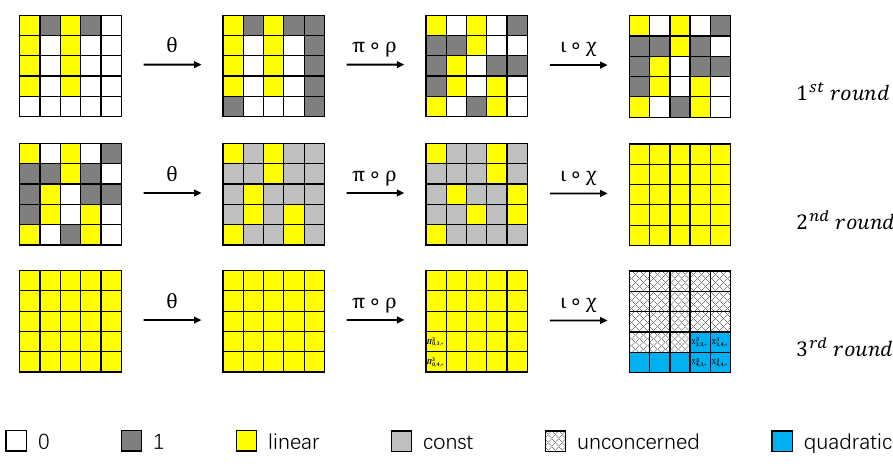
Figure 5: The 2.5-round linear structure for 3-round